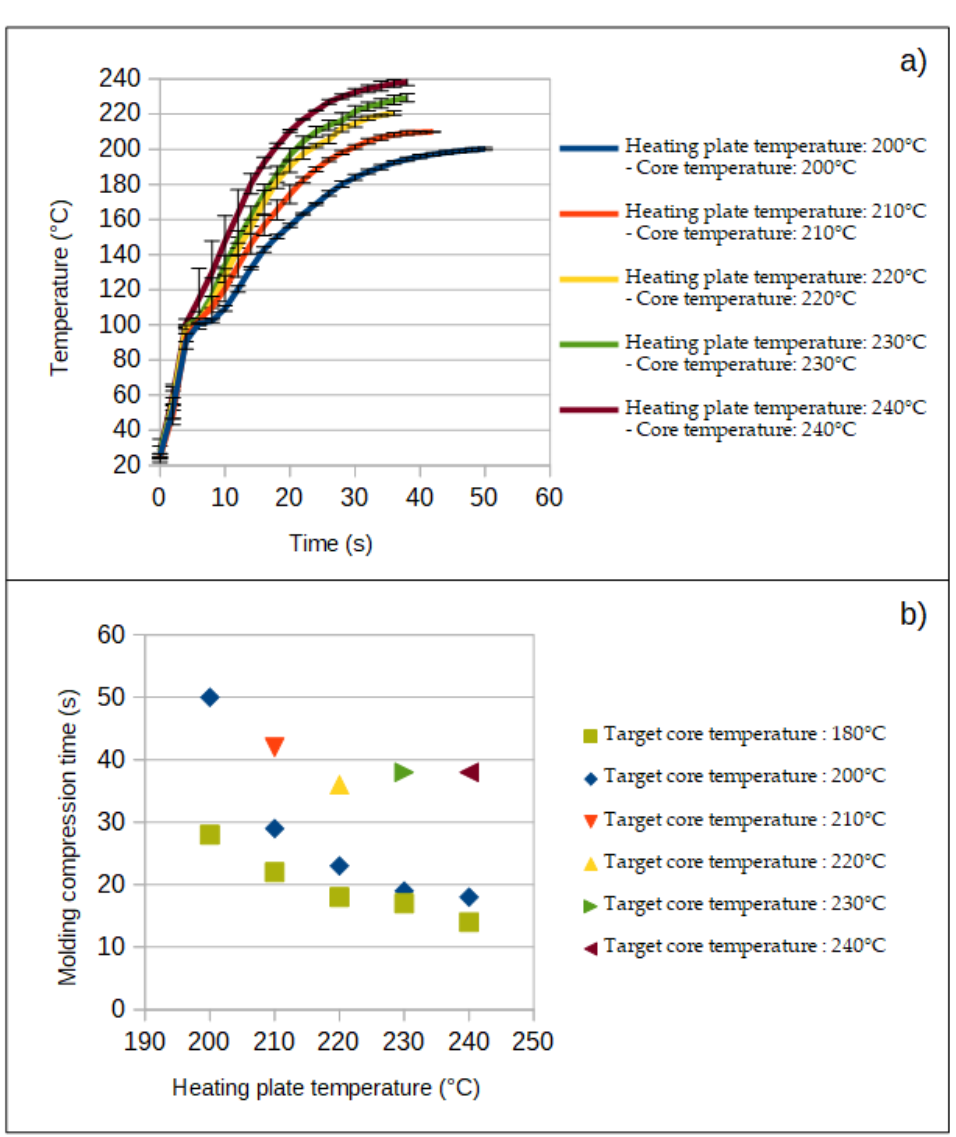
Figure 2. Evolution of the temperature of the non-woven in situ and in real time during the compression molding process: ( a ) temperature versus time and ( b ) molding compression time versus heating pate temperature for different target core temperatures.